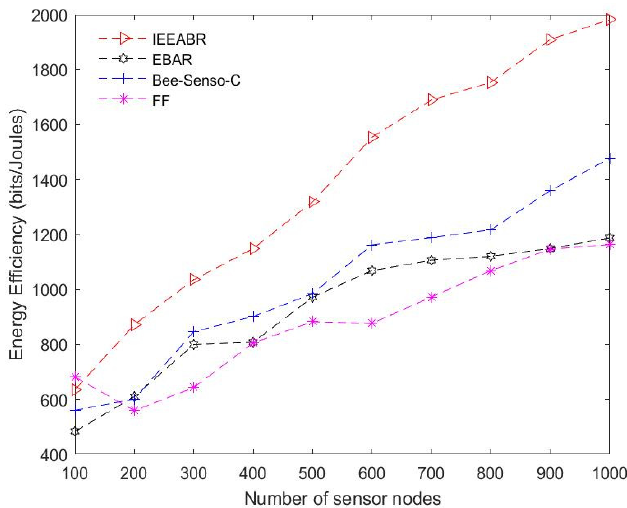
Figure 18. Comparison in terms of energy efficiency.